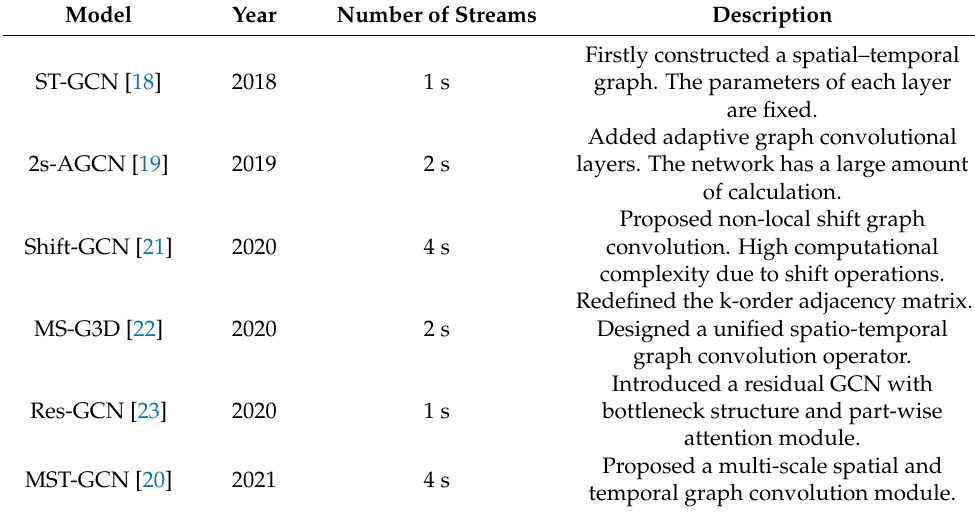
Table 1. Summary of Existing GCN